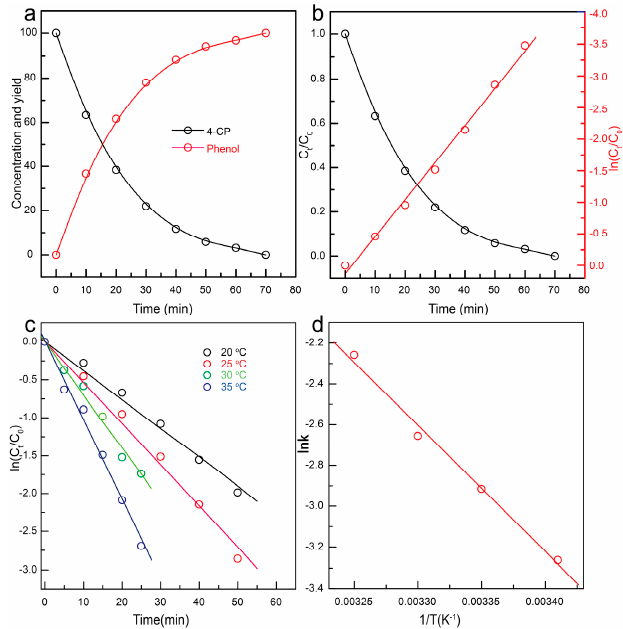
Figure 4. ( a ) Time course of evolution of the yield of phenol and conversion of 4-CP catalyzed by Pd/alk-Ti 3 C 2 X 2 catalyst at 25 °C. ( b ) Plots of C t /C 0 and ln ( C t / C 0 ) vs. time for the HDC of 4-CP. ( c , d ) Plots of ln ( C t / C 0 ) vs. time at different temperatures and the Arrhenius plots.